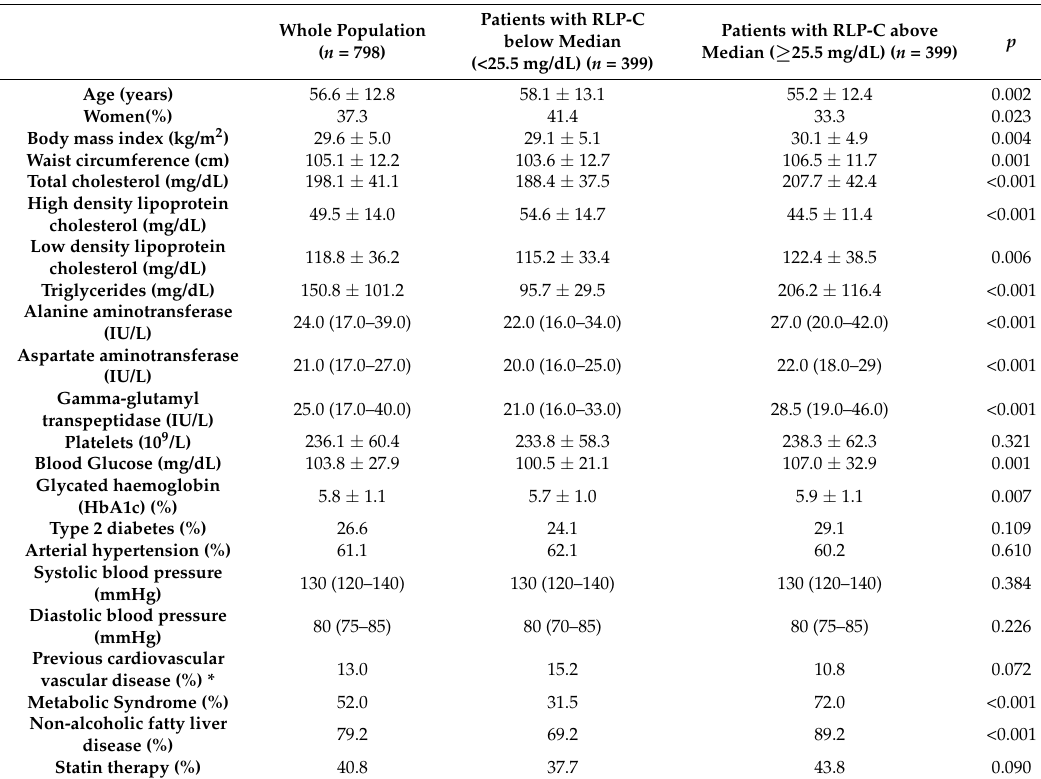
Table 1. Characteristics of patients with fasting remnant lipoprotein cholesterol (RLP-C) below and above median.